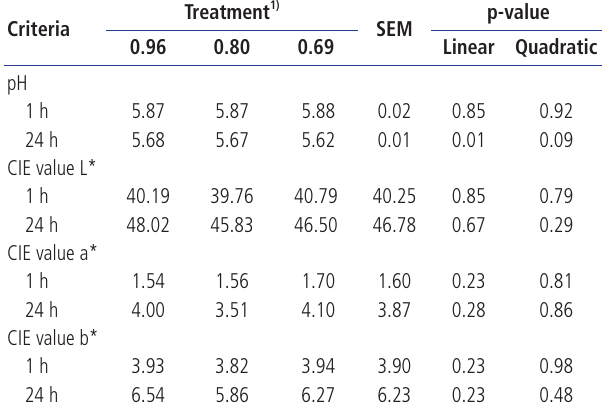
Table 4. Effect of different space allowance on immunological response in growing- finishing pigs Criteria